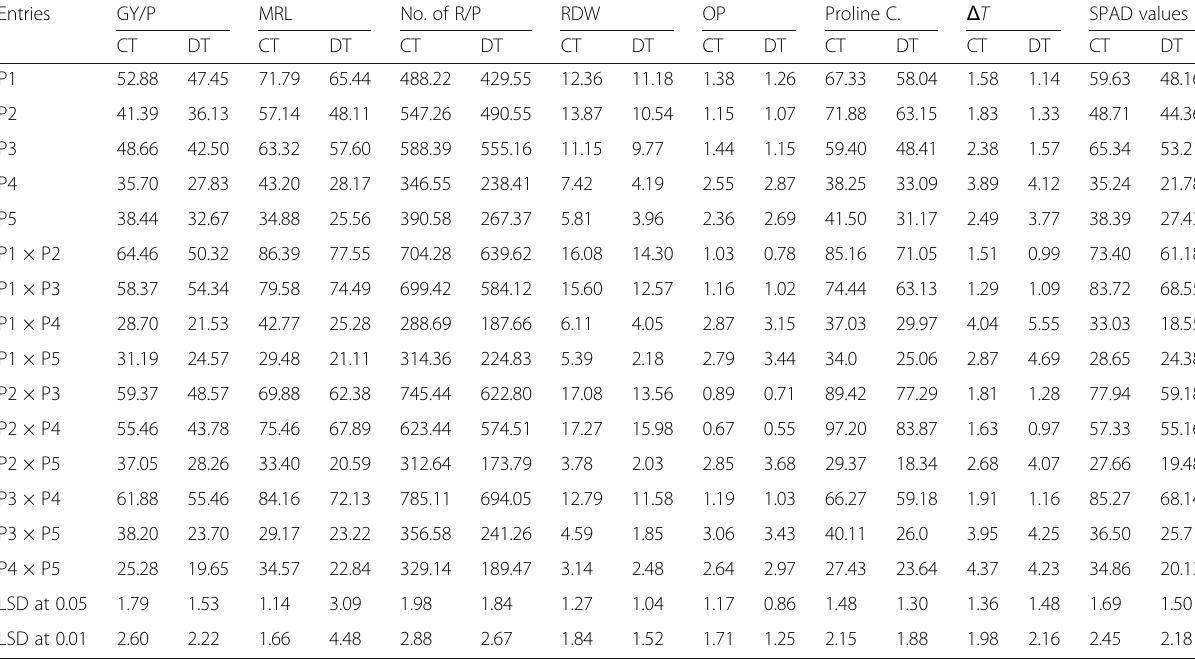
Table 3 Mean performances of all entries for all studied traits in sorghum accessions under the control treatment of irrigation and water stress